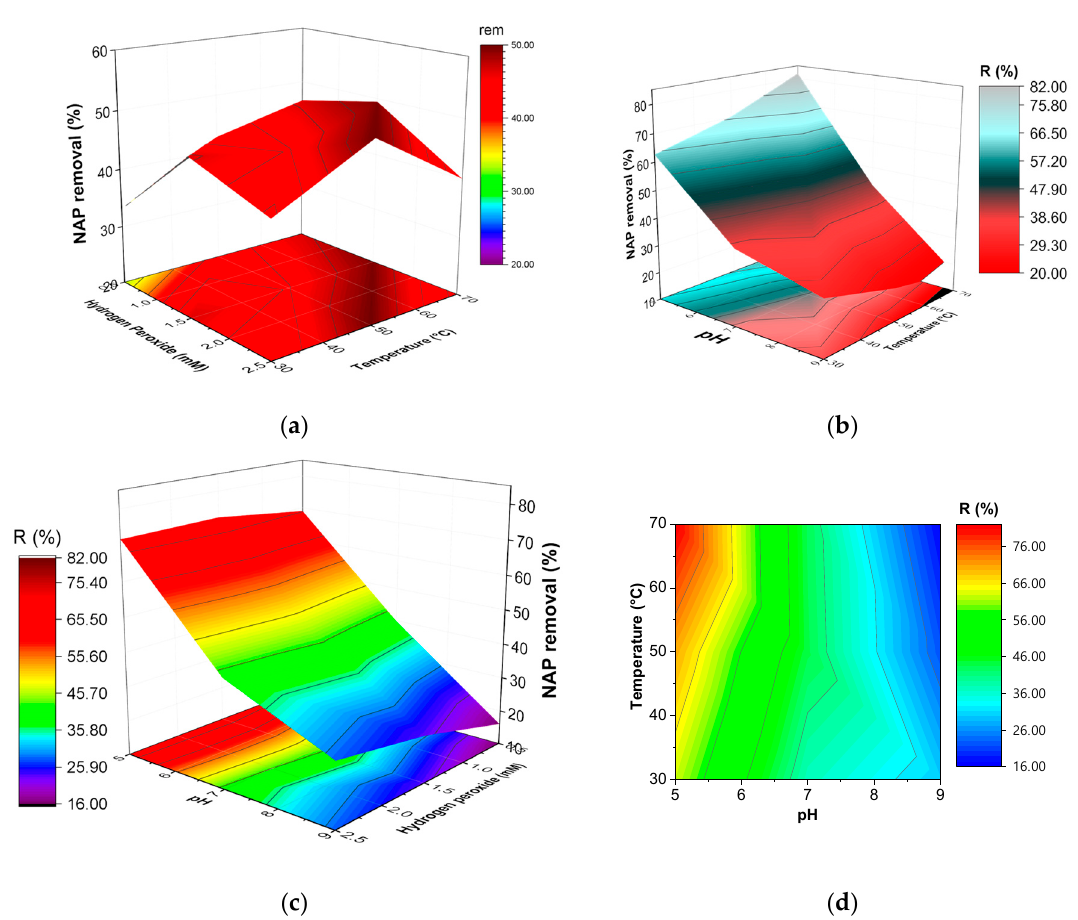
Figure 6. Combined effect of ( a ) H 2 O 2 vs. temperature, ( b ) H 2 O 2 vs. pH, and ( c ) pH vs. temperature on the NAP removal; ( d ) contour plot of temperature and pH on the NAP removal.